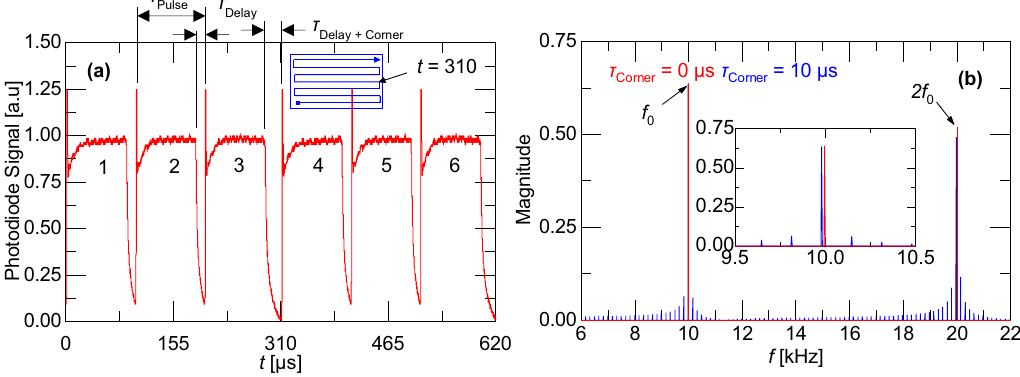
Figure 3. (a) Normalized experimental photodiode waveform with inset showing raster scan path for τ Pulse = 100 µs and (b) corresponding signal in the frequency domain with and without